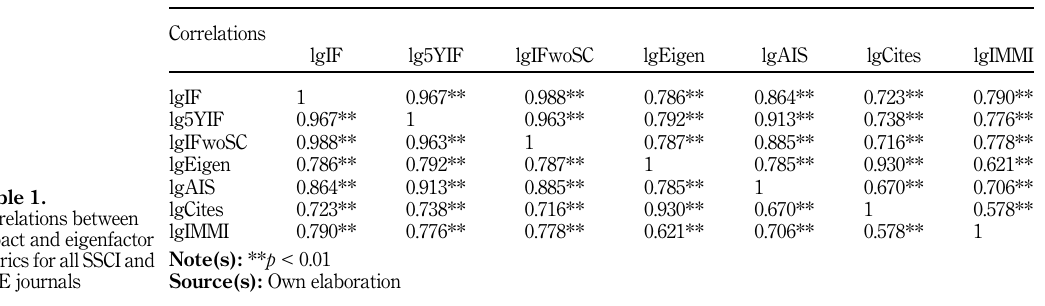
Table 1. Correlations between impact and eigenfactor metrics for all SSCI and SCIE